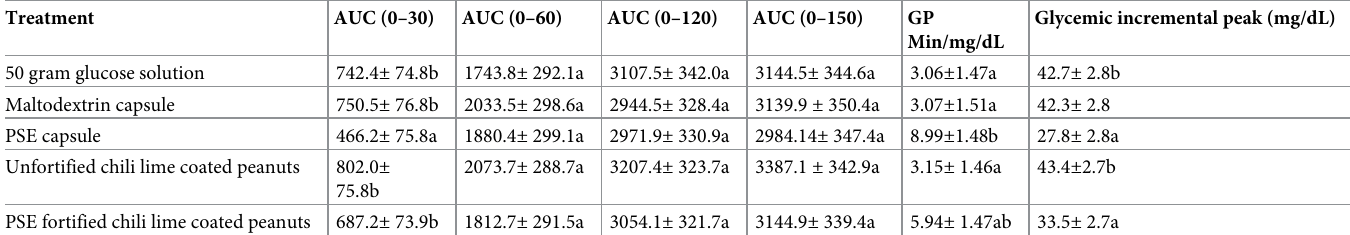
Table 1. Blood glucose responses in 15 healthy individuals after 5 treatments in oral glucose tolerance test. The change in glucose level from fasting level was plotted against the time for 2.5 hours in glycemic response curve. Glucose levels were measured using a continuous glucose monitor. The area under the curve (AUC), glycemic profile, and glycemic incremental peak were determined from the glycemic response